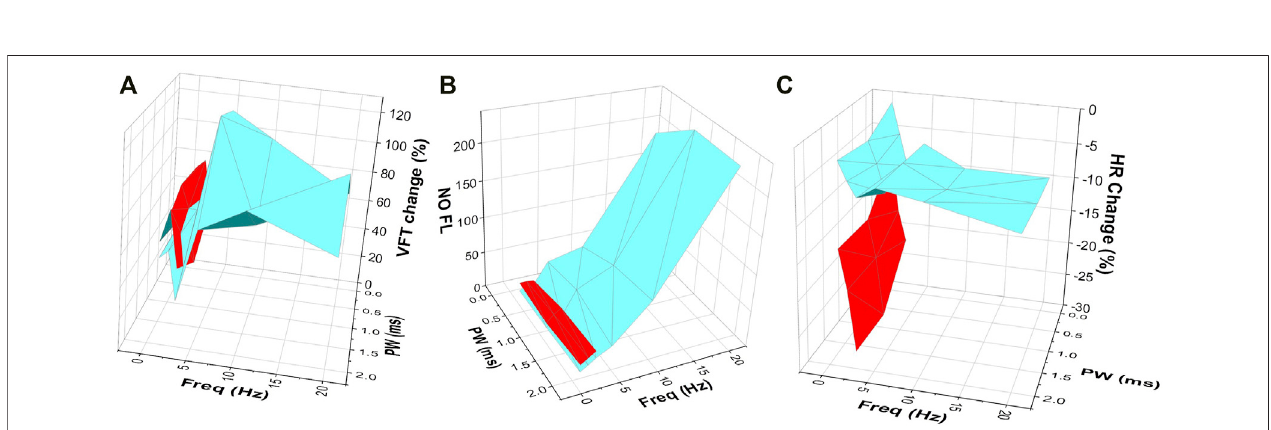
FIGURE 4 | The effects of VNS at varying stimulation parameters on (A) VFT (B) NO fl uorescence and (C) HR change. Three-dimensional plots illustrating the effects of varying stimulation parameters on changes in VFT, NO fl uorescence and heart rate, highlighting the important effect of VNS at high voltages and low frequencies (red) on heart rate (C) , with low voltage and high frequency stimulation (blue) producing a more prominent effect on VFT (A) and NO release in the ventricle (B) . Data in red represents high voltage stimulation. Data in blue represents low voltage stimulation.